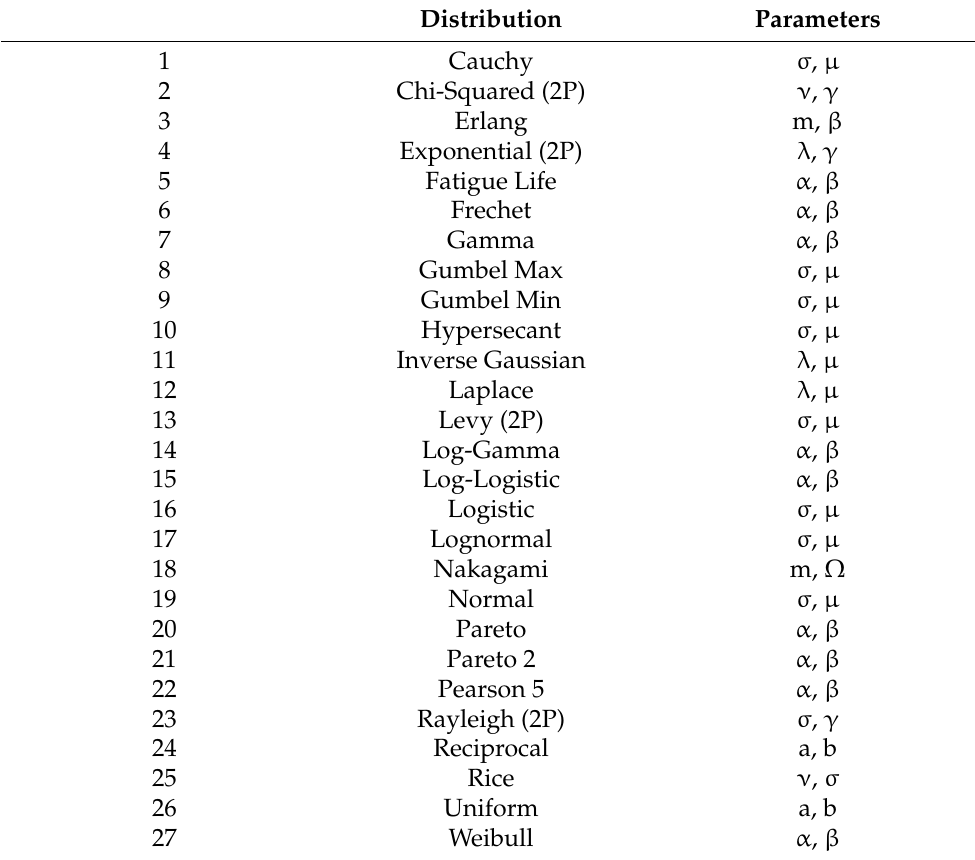
Table 6. List of tested two-parameter continuous distributions.